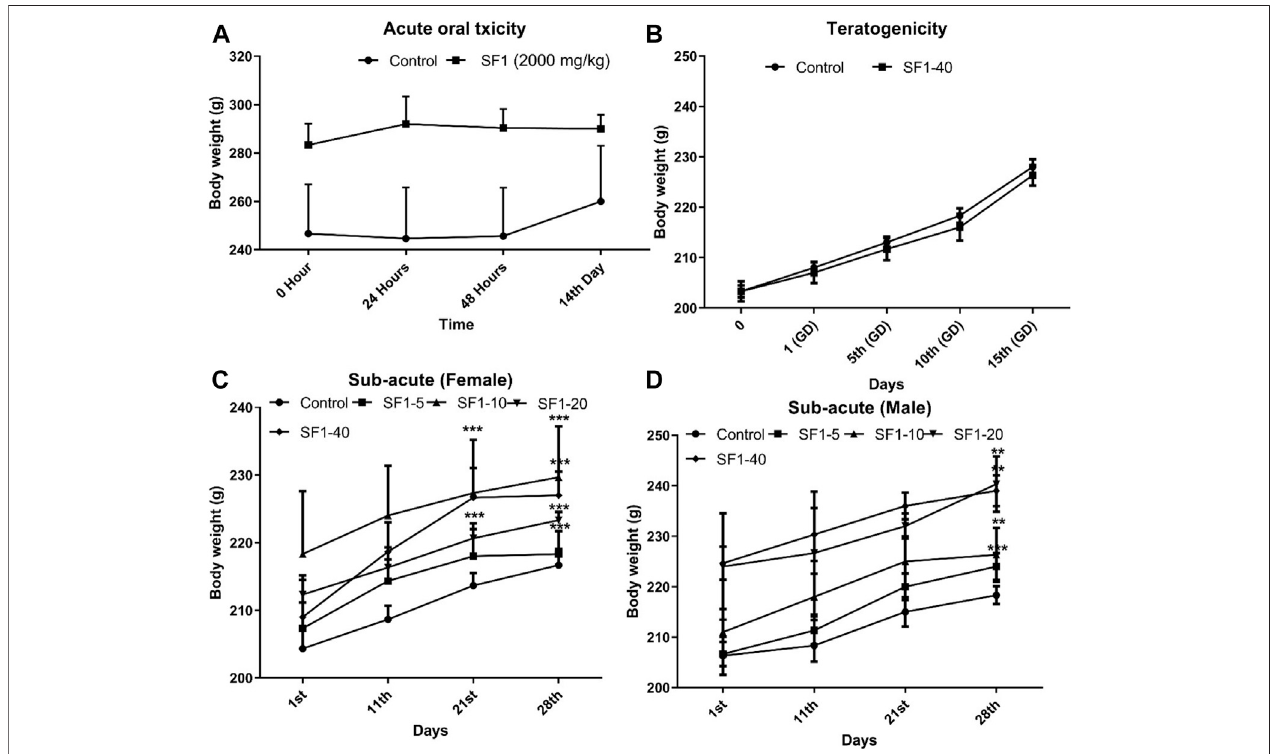
FIGURE2| Effectoftreatmentsonbodyweightsduringacute (A) ,subacute (C,D) ,andteratogenictoxicity (B) studies.Dataisrepresented asmean ± SEM; n (cid:1) 5 for acute and n (cid:1) 10 for teratogenicity and subacute toxicity studies, * p < 0.05, ** p < 0.01 and *** p < 0.001 when compared with day 1.